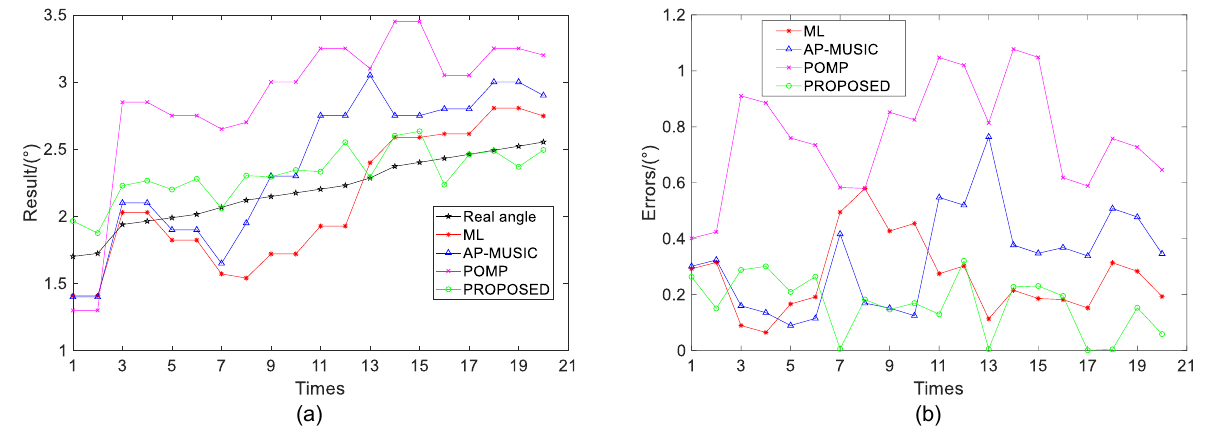
Figure 7. The RMSE results of measured data. ( a ) The RMSE results of different algorithms on the measured data. ( b ) The error results of different algorithms measured on the measured